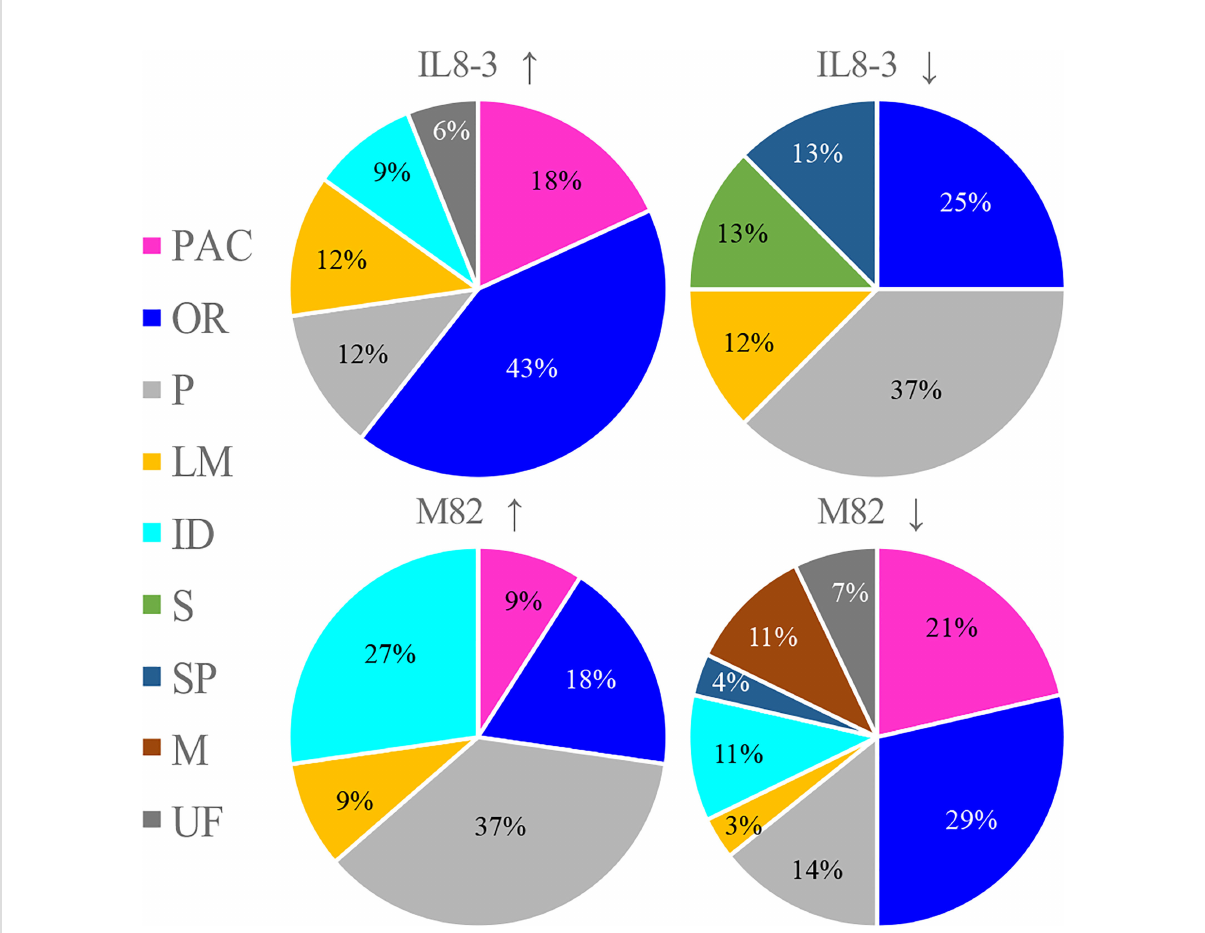
FIGURE 3 Overview showing the distribution in functional classes of the cell wall protein (http://www.polebio.lrsv.ups-tlse.fr/WallProtDB/). Cultivars with up arrow and with down arrow represent the increased and decreased in protein abundance in response to salt stress, respectively. PAC stands for proteins acting on carbohydrates, OR for oxido-reductases, P for proteases, LM for proteins related to lipid metabolism, ID for proteins with interaction domains, S for signaling, SP for structural proteins, M for miscellaneous and UF for unknown